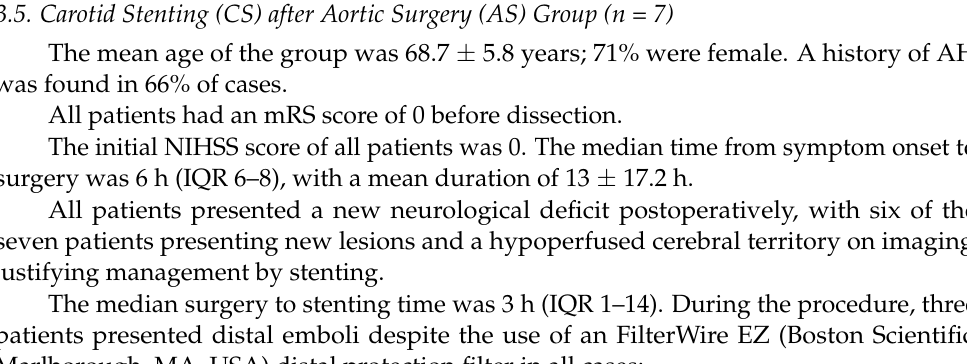
Figure 2. Local cohort case of a 72-year-old, who suffered a brutal left hemicorporal deficit. CT scan showed an AAD extended to the LCCA, with a subocclusive compression of the true lumen ( a – c ). Initial MRI showed a significant mismatch between the limited cytotoxic lesion of the rolandic area, and the hypoperfusion of the entire sylvian territory ( d ). Preoperative angioplasty was decided ( e ) The initial occlusion is shown. Stenting allowed to re-expand the true lumen, with coverage of the entire carotid dissection ( f ). The patient underwent aortic surgery 6 h later, without complications, and recovered gradually after. Post-surgical MRI (not shown) found no new cytotoxic lesion, and showed complete resolution of the